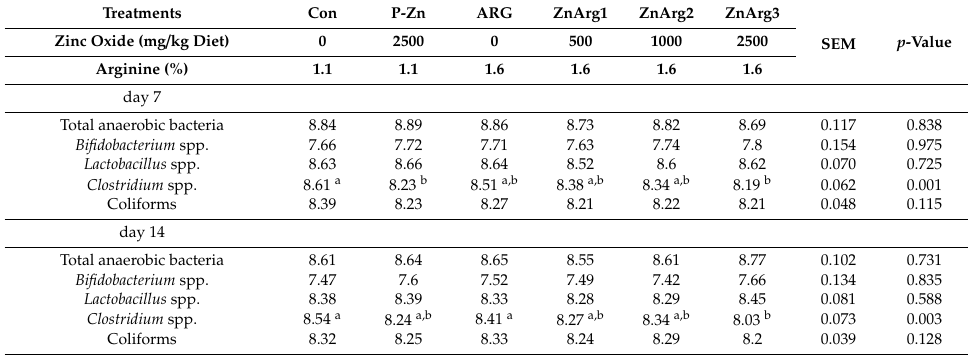
Table 4. E ff ect of dietary zinc and arginine on intestinal microbiota of weanling piglets fed diets supplemented with or without zinc and arginine exposed to high temperature. Treatments Con P-Zn